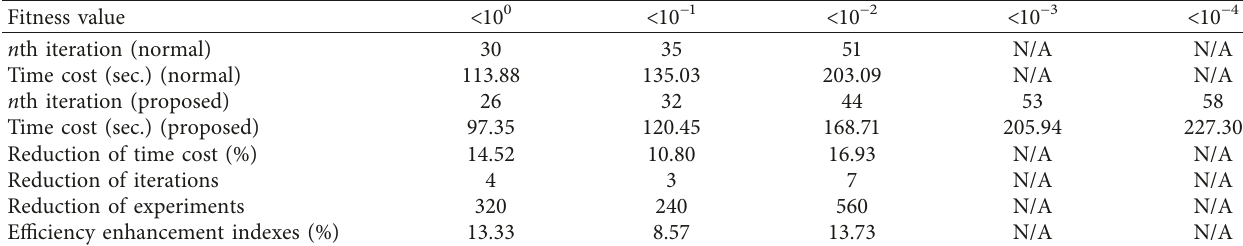
Table 4: The cost comparisons of the improved method and the normal Taguchi method.